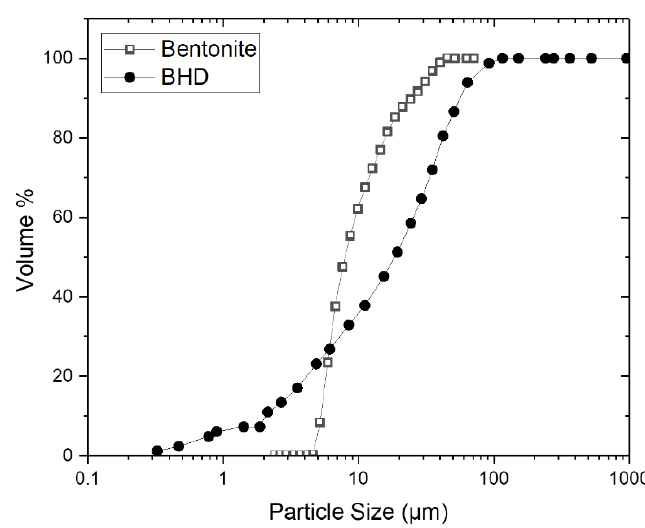
Figure 5. Mass percent of size distribution for steel dust (BHD) compared to bentonite.